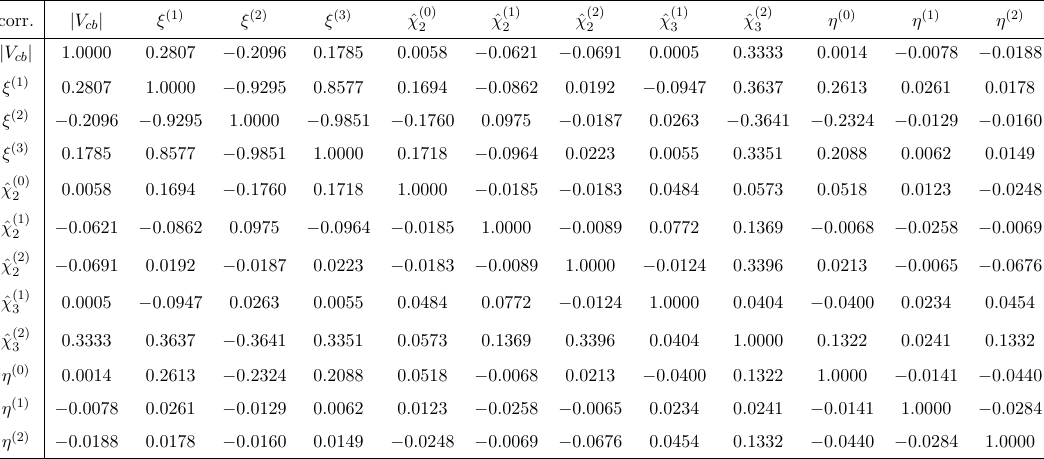
n (cid:24) ( n ) ; ^ (cid:31) ( n )